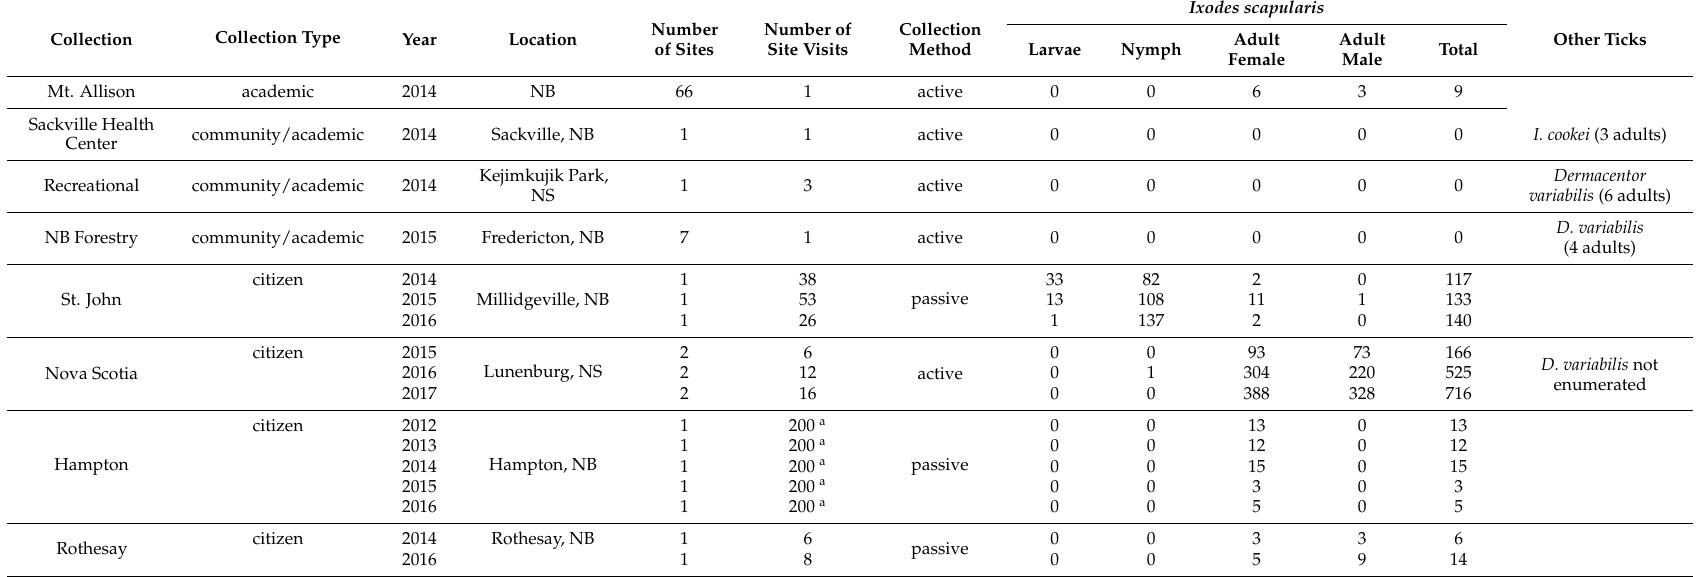
Table 1. Tick recoveries from academic and community-initiated surveillance